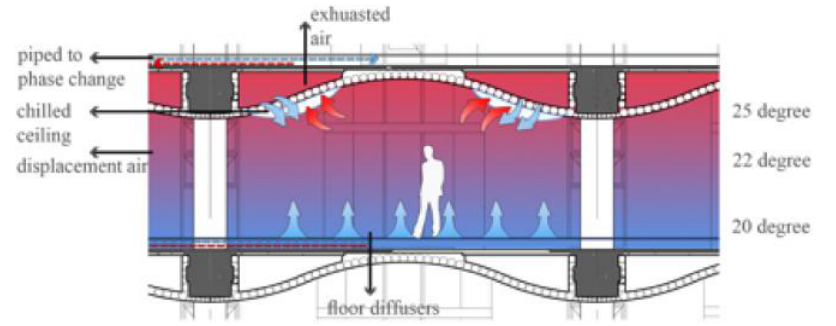
Fig. 4: functional diagram of internal air cooling by the chillers embedded in the ceilings (Tan, 2007)